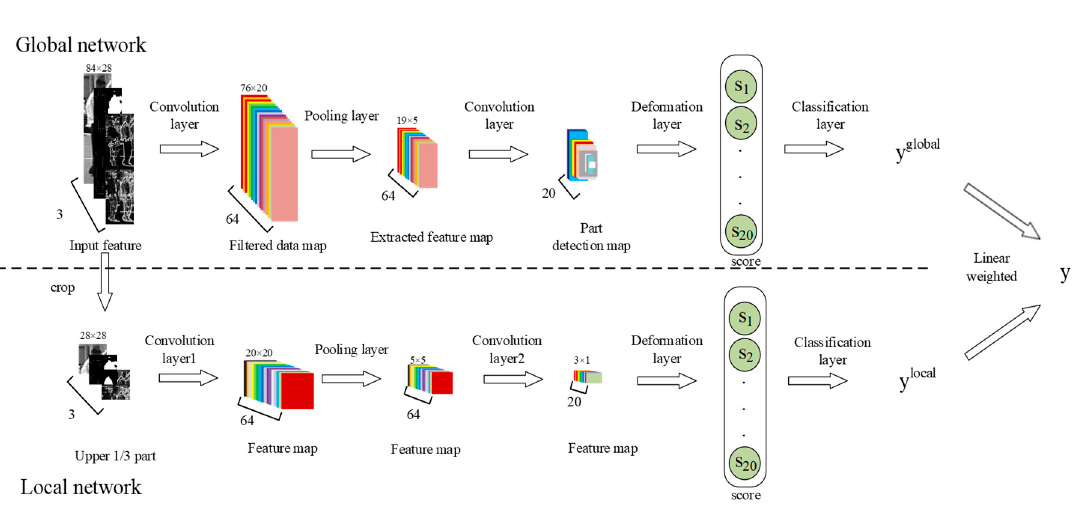
Figure 5. Examples of misjudged images with improved UDN.